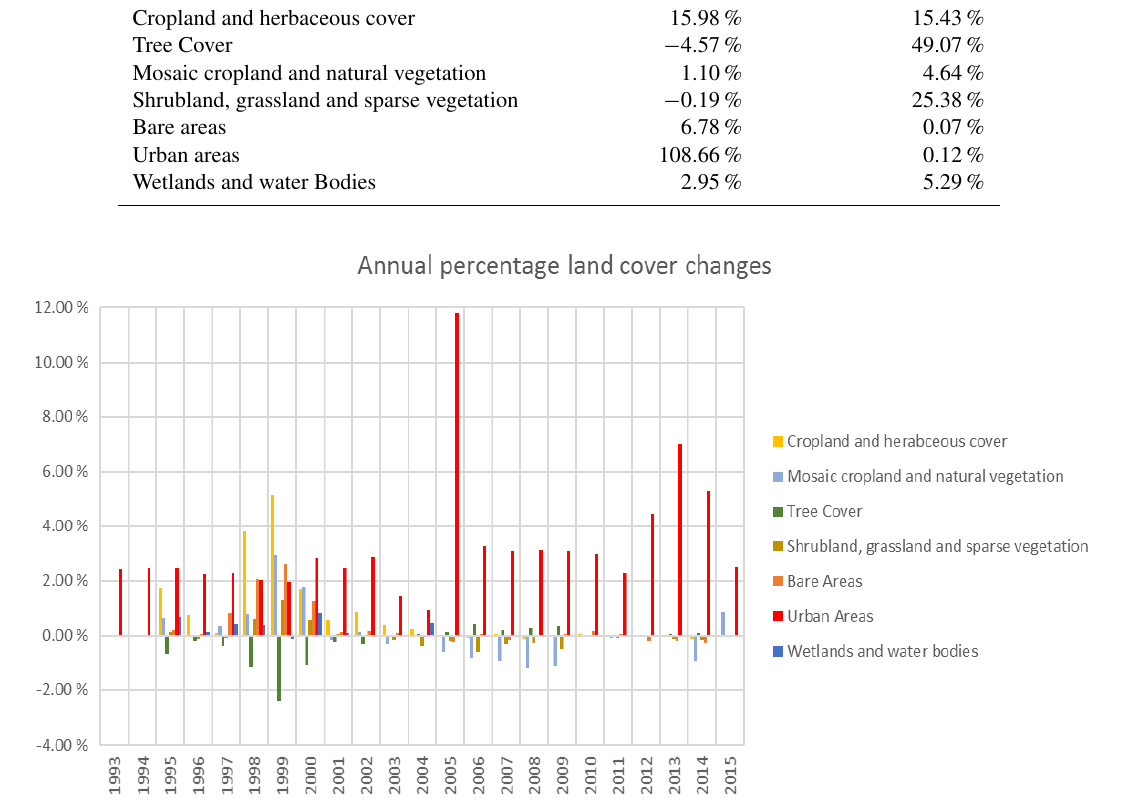
Figure 6. Annual % land cover changes in the Zambezi for the 7 broad classes.